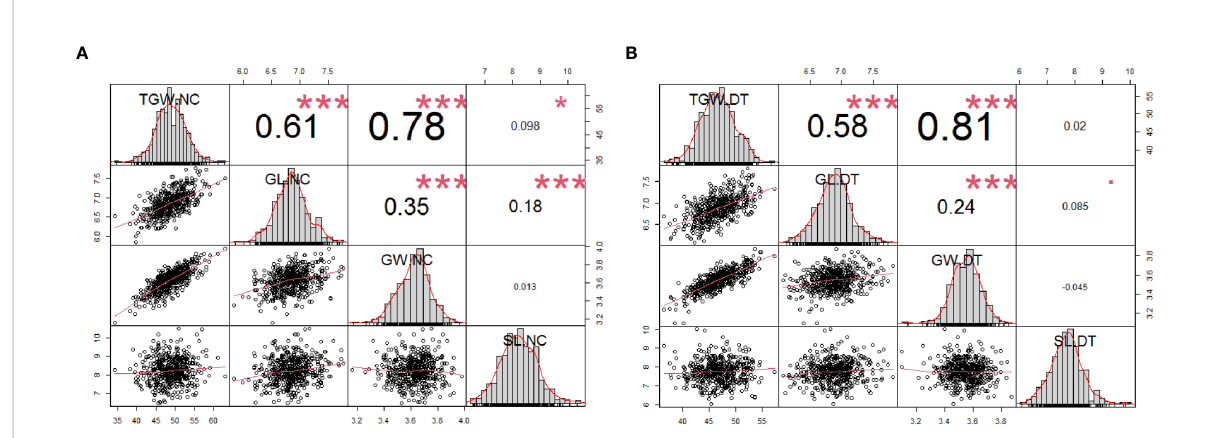
FIGURE 2 Phenotypic performances, distribution, and correlation coef fi cients for the 502 wheat accessions using the average phenotypic data under normal (A) and drought treatment conditions (B) . The frequency distribution of the phenotypic data for each trait is shown in the histograms. The X - Y scatter plot with the adjusted Pearson ’ s coef fi cients. * P < 0.05, *** P < 0.001. TGW.NC, thousand-grain weight under normal conditions; GL.NC, grain length under normal conditions; GW.NC, grain width under normal conditions; SL.NC, spike length under normal conditions; TGW.DT, thousand-grain weight under drought treatment conditions; GL.DT, grain length under drought treatment conditions; GW.DT, grain width under drought treatment conditions; SL.DT, spike length under drought treatment